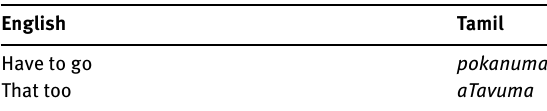
Table 3: Example English Phrases and Equivalent Tamil Words.